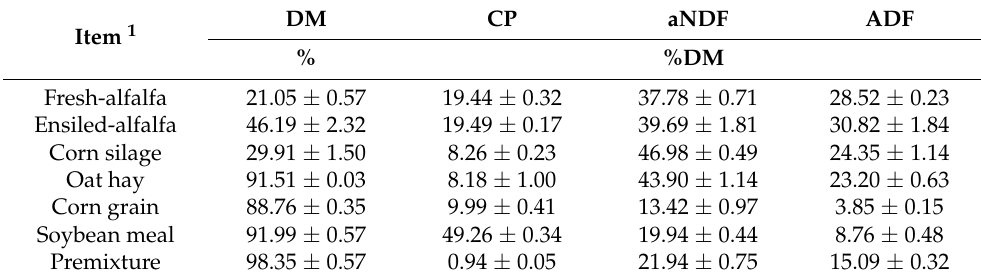
Table 2. The chemical composition of each ingredient and fresh-alfalfa and ensiled-alfalfa FTMR before fermentation.